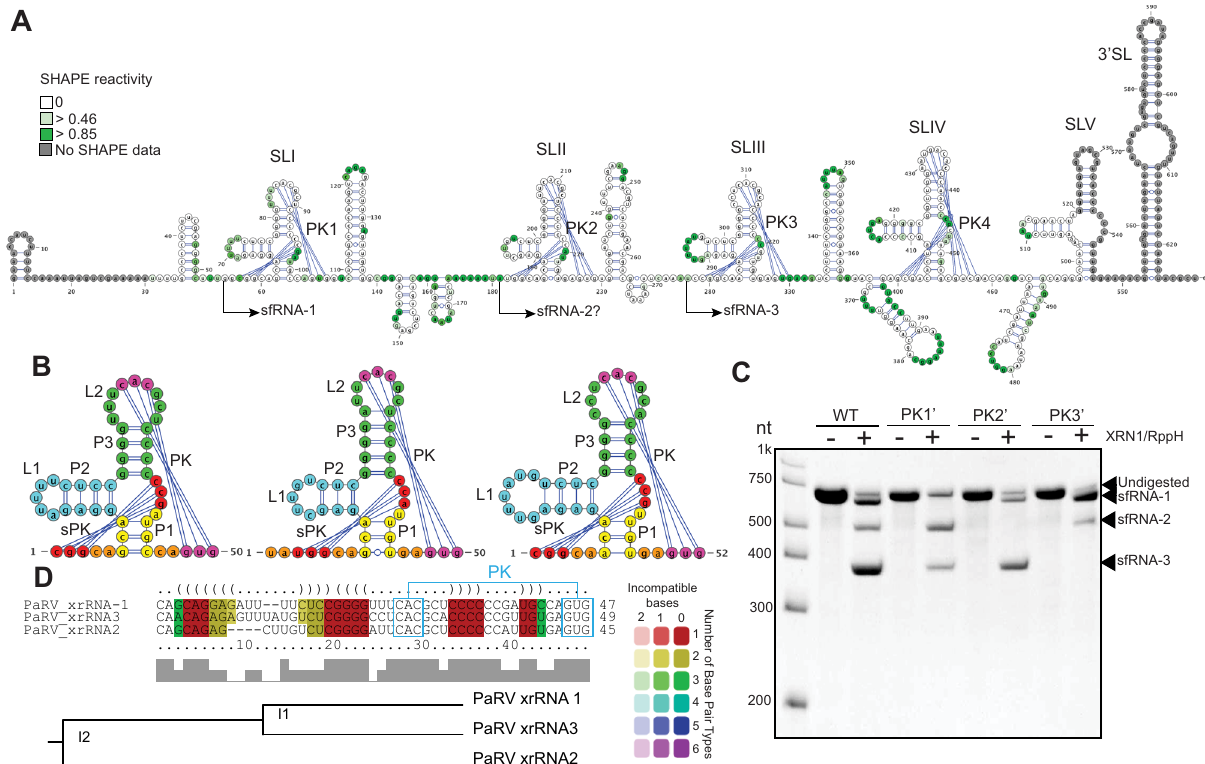
Fig. 3 cISFs PaRV contains multiple copies of divergent class 1b xrRNAs. A Secondary structure of PaRV 3 ’ UTR generated using SHAPE-assisted folding. Colour intensity indicates NMIA reactivity. Values are the means from 3 independent experiments, each with technical triplicates. SL – stem loop, PK -pseudoknot. B Secondary structure of PaRV xrRNAs. Each structural element is shown in colour. C In vitro XRN1 resistance assay with WT and mutated PaRV 3 ’ UTRs. PK1 ’ , PK2 ’ and PK3 ’ mutations were introduced into the terminal loop regions of SLI, SLII and SLIII, respectively, and represented the CAC - > GUG change in the PK-forming regions. Image is representative from three independent experiments that showed similar results. D Structure-based alignment of PaRV xrRNAs was performed using